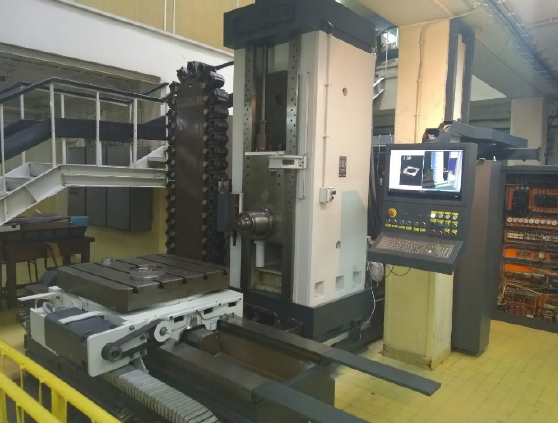
Figure 1. LOLA HBG 80 horizontal machining center